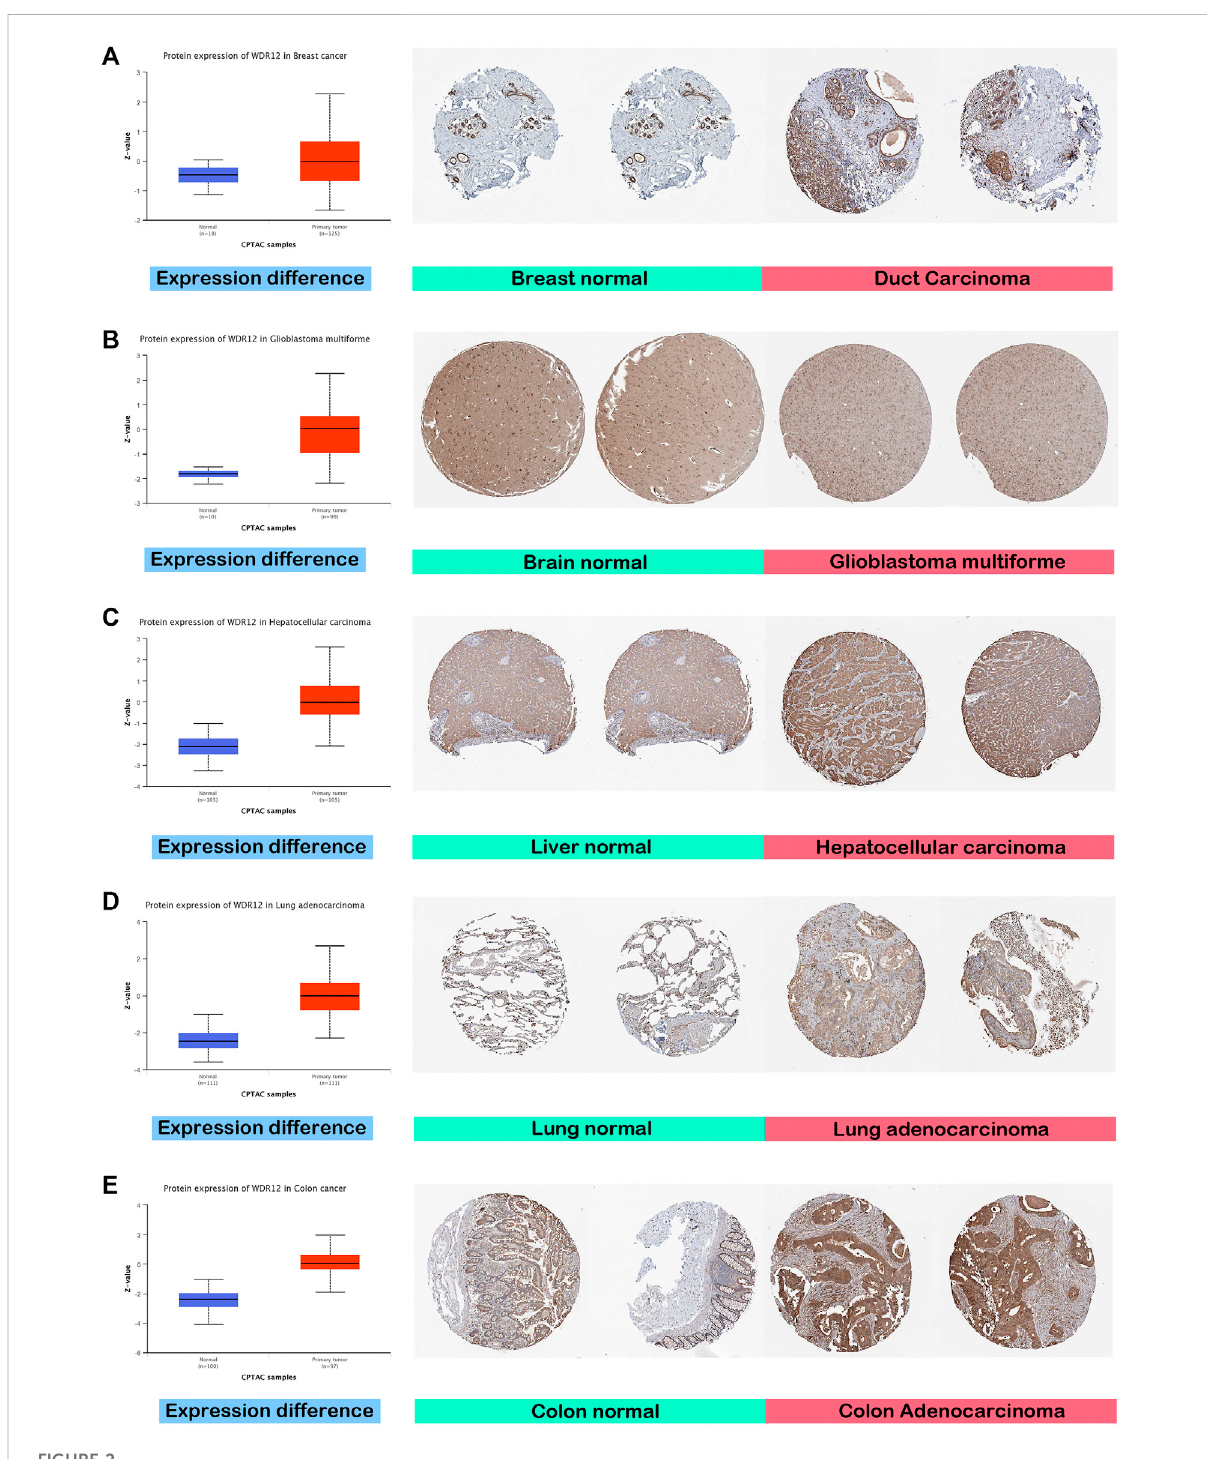
FIGURE 2 Tumors experienced a statistically signi fi cant higher WDR12 protein expression in the tumor sample versus the normal one (left side); IHC staining for normal tissue (middle) and cancerous one (left) demonstrated the same results. (A) Breast; (B) Brain; (C) Liver; (D) Lung; (E)